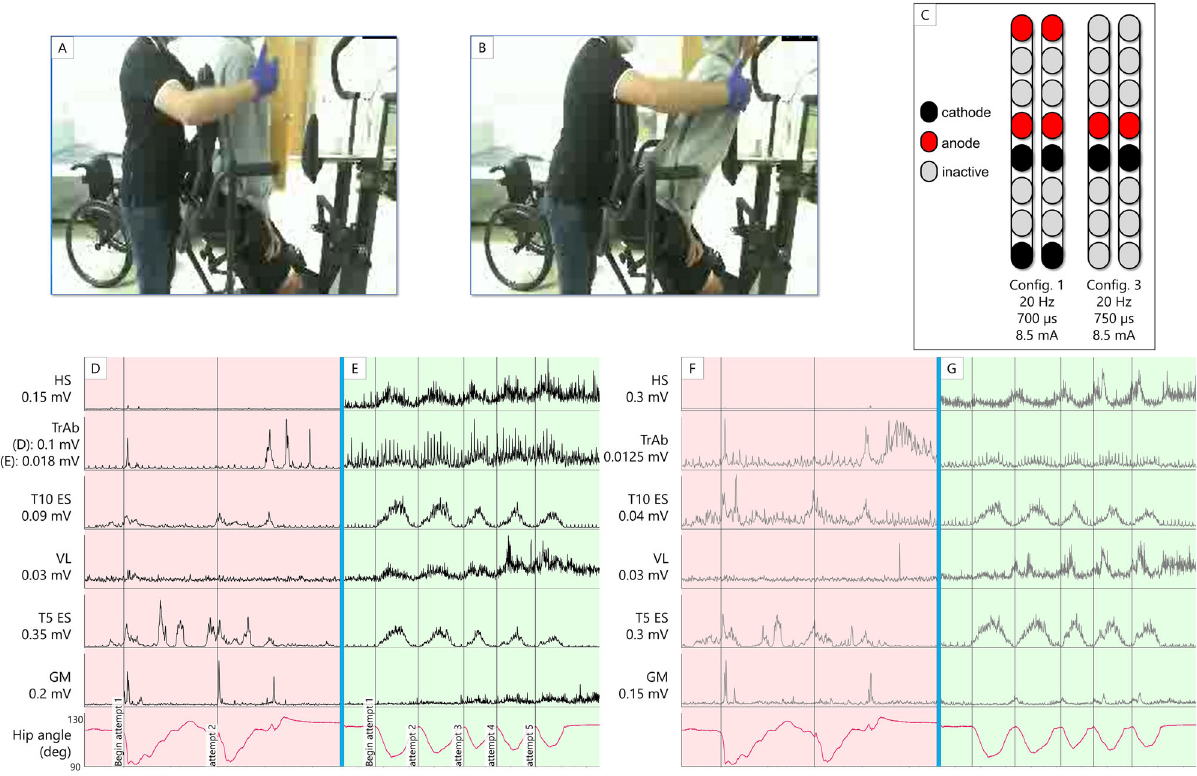
Fig. 4 | Voluntary hip fl exion and extension with trunk control (participant 0772) from a semi-standing position in a standing frame. Panels A and B show the start and end of the range of motion, respectively, the participant attempts withoutself-assistancefromthearmsorexternalassistance.Astudyteammember is seen guarding the participant for safety. C SCES con fi gurations and stimulation parameters. D – G root mean square EMG activation of trunk (T5 ES and T10 ES: erector spinae muscles at T5 or T10 vertebral levels respectively; TrAb: transverse abdominis muscles) and leg muscles. Trunk EMGs had an additional comb fi lter applied to remove SCES artifact 27 , while ECG artifact is still visible. Hip angle is derived from an electrogoniometer on the participant ’ s hip. Panels D and F show left and right-sidemuscles,respectively, with the hip angle tracereplicatedin both panels,whiletheparticipantattemptsthemaneuverwithSCESoff.BurstsseeninES and gluteal muscles(GM)are likelyre fl exive, asthey occur synchronously with the rapid decline in hip angle as the participant was unable to control his